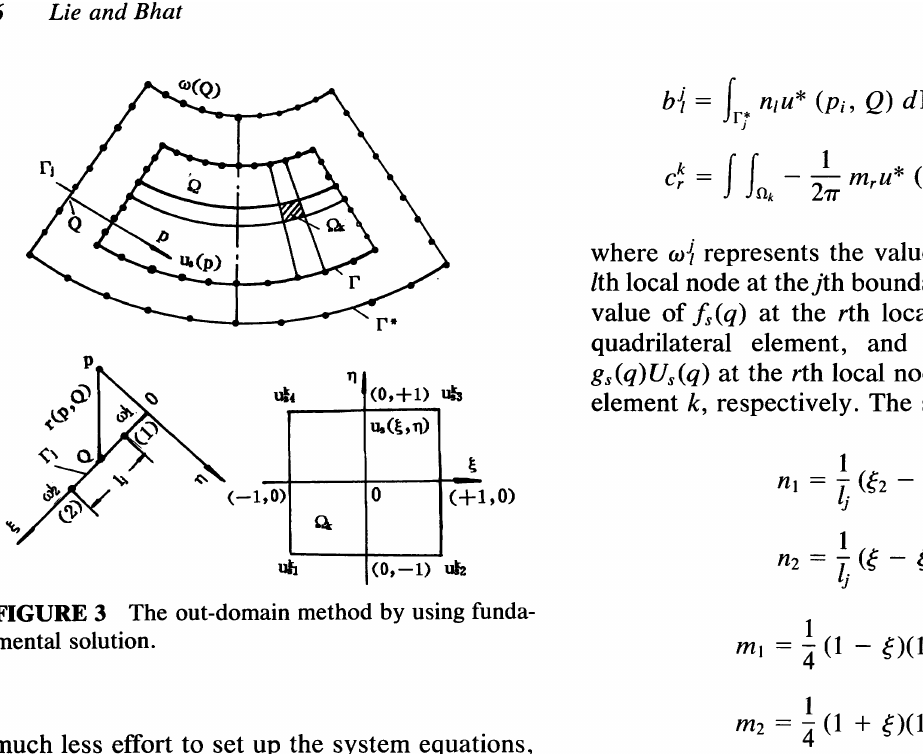
FIGURE 3 The out-domain method by using funda mental